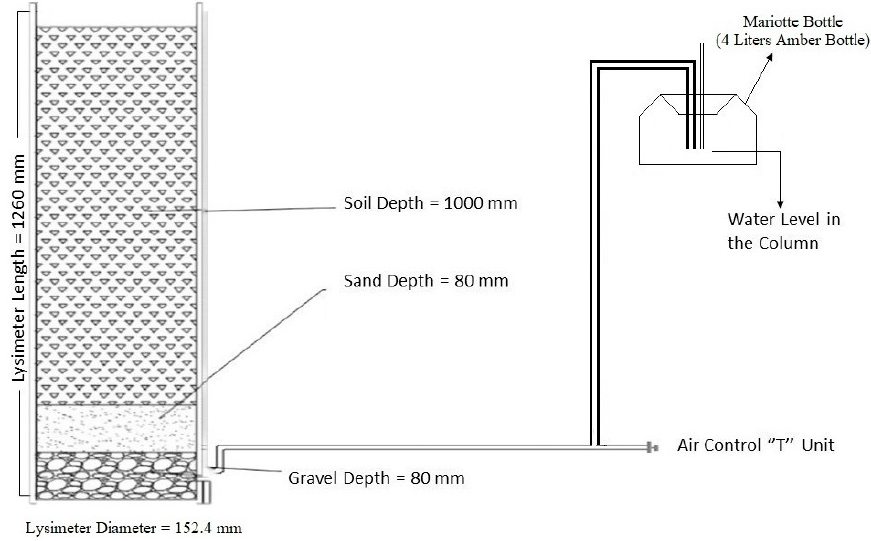
Figure 1. Schematic diagram of a lysimeter and Mariotte bottle system.